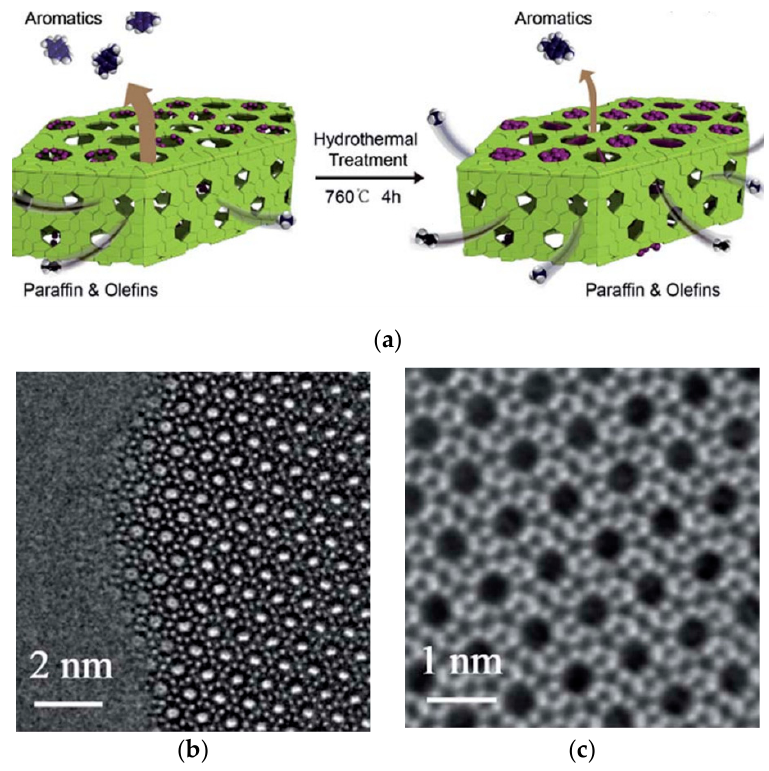
Figure 9. ( a ) MTA schematic; ( b ) HAADF-STEM of the synthesized ZSM-5; ( c ) iDPC-STEM Reprinted/adapted with permission from Ref. [92]. Copyright 2011, Royal Society of Chemistry.